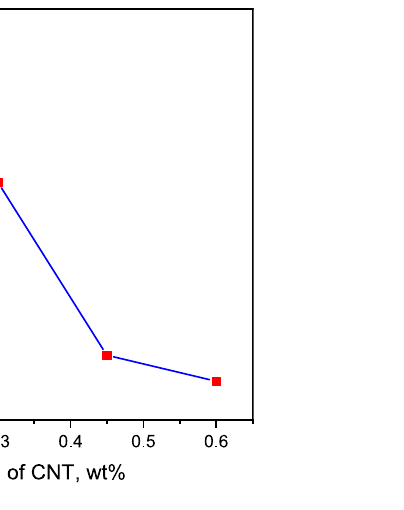
Figure 1. Flowability of sonicated CNT-LWAC